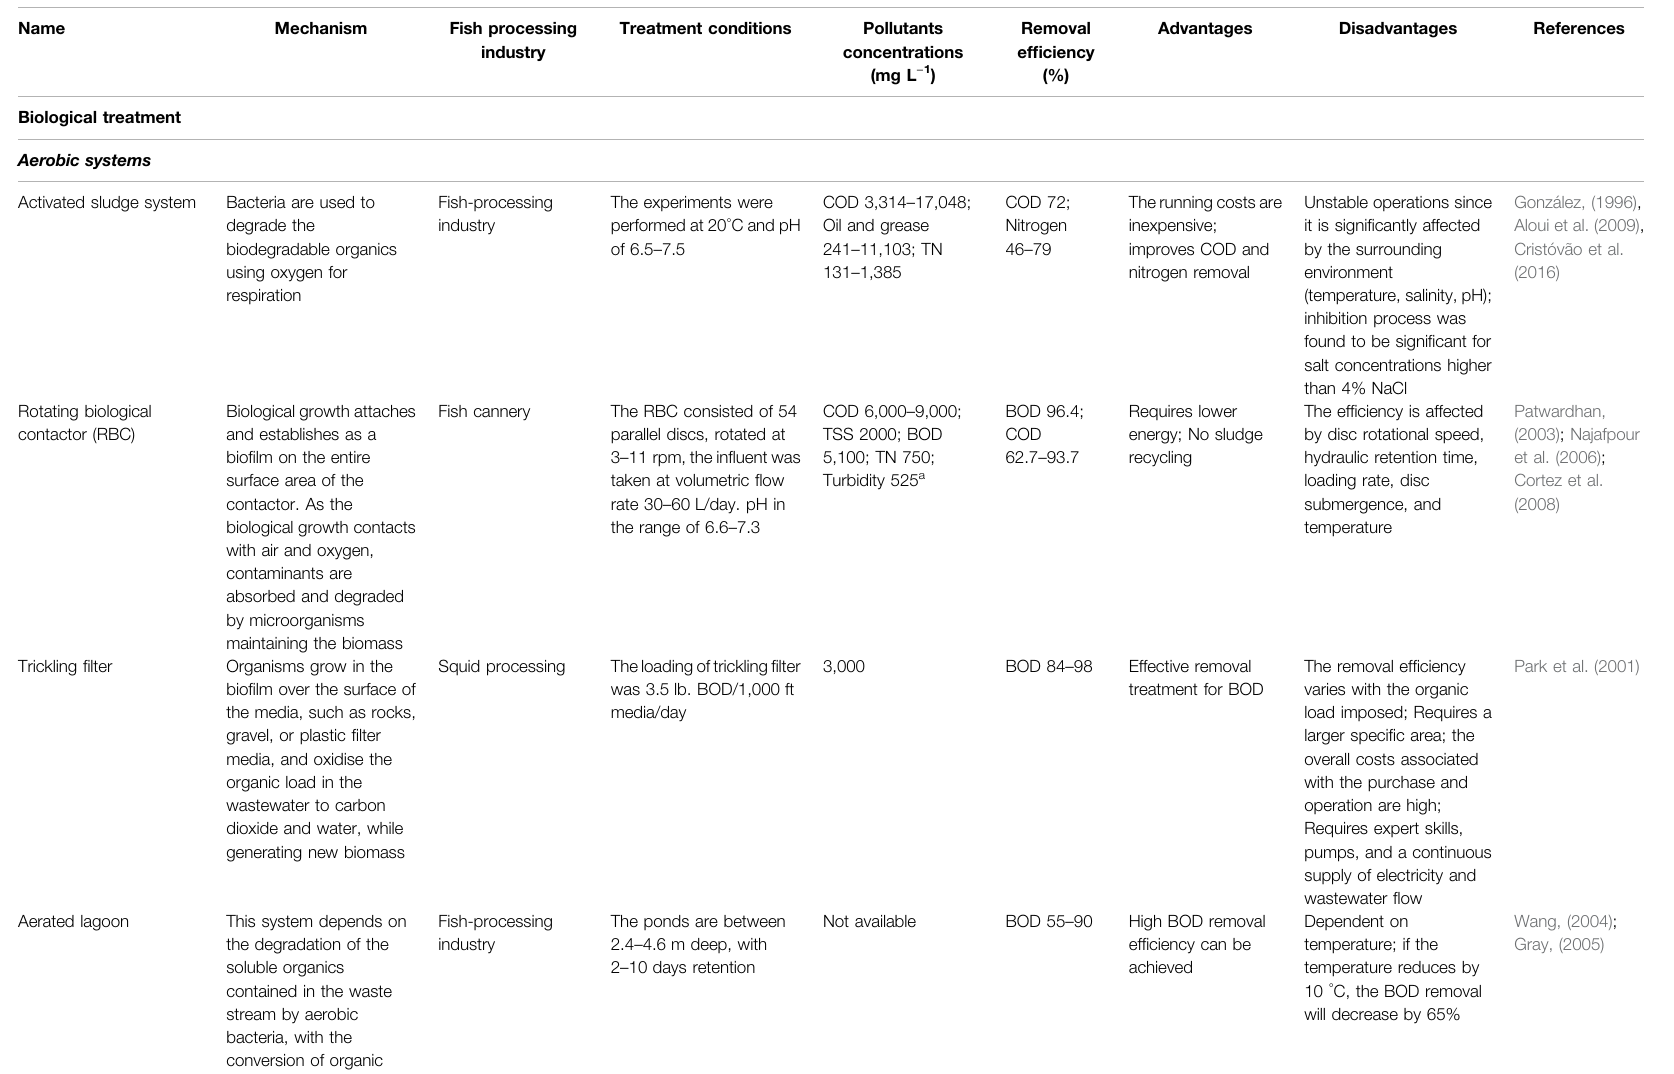
TABLE 2 | ( Continued ) The advantages and disadvantages of current fi sh wastewater treatment